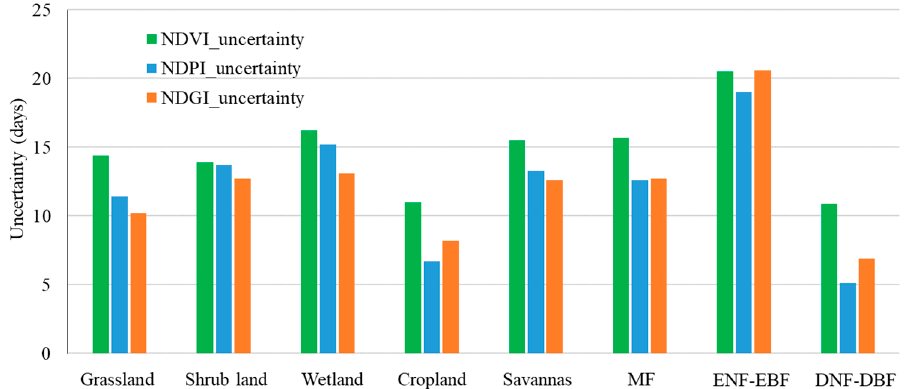
Figure 8. The relationship between GUD uncertainty and vegetation types. We averaged the value of GUD uncertainty over all pixels within each vegetation type. For the definition of each vegetation type, please refer to Figure 5.